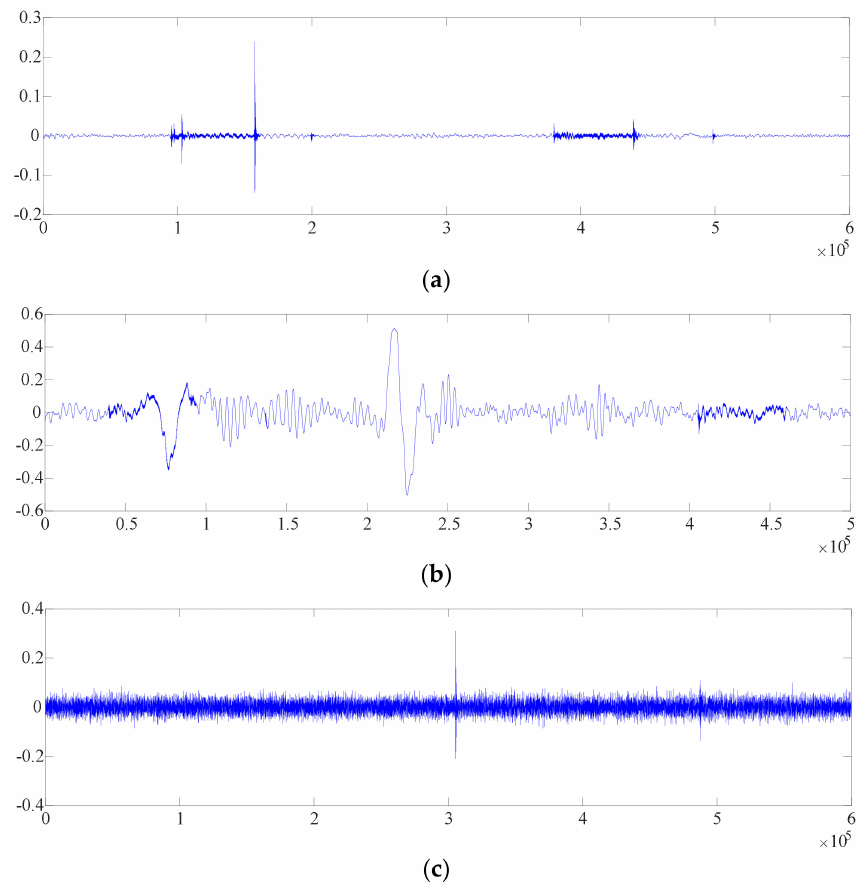
Figure 4. Time domain signals for the three operating conditions. Number of samples on the x -axis, magnitude on the y -axis, ( a ): Abnormal sound of rearview mirror, ( b ): Normal sound of rearview mirror, ( c ): Normal sound of rearview mirror under routine laboratory